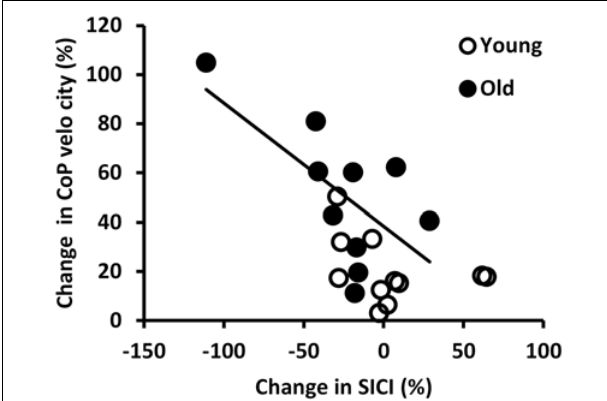
FIGURE 4 | Correlation between the percent changes in short interval intracortical inhibition (SICI) and center of pressure (CoP) velocity from the rigid to the foam condition in young and old adults. The regression line illustrates that in old subjects greater reductions in SICI were accompanied by greater increases in CoP velocity ( r = − 0.648, p =